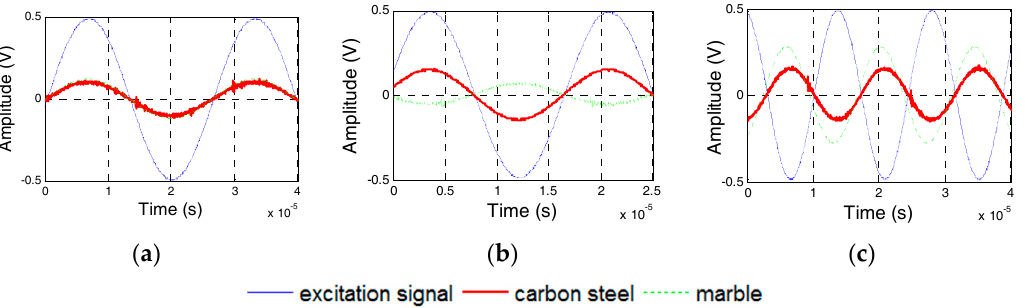
Figure 17. PZT transducer signal of Specimen 1. ( a ) 38 kHz Excitation Frequency; ( b ) 52 kHz Excitation Frequency; and, ( c ) 70 kHz Excitation Frequency.